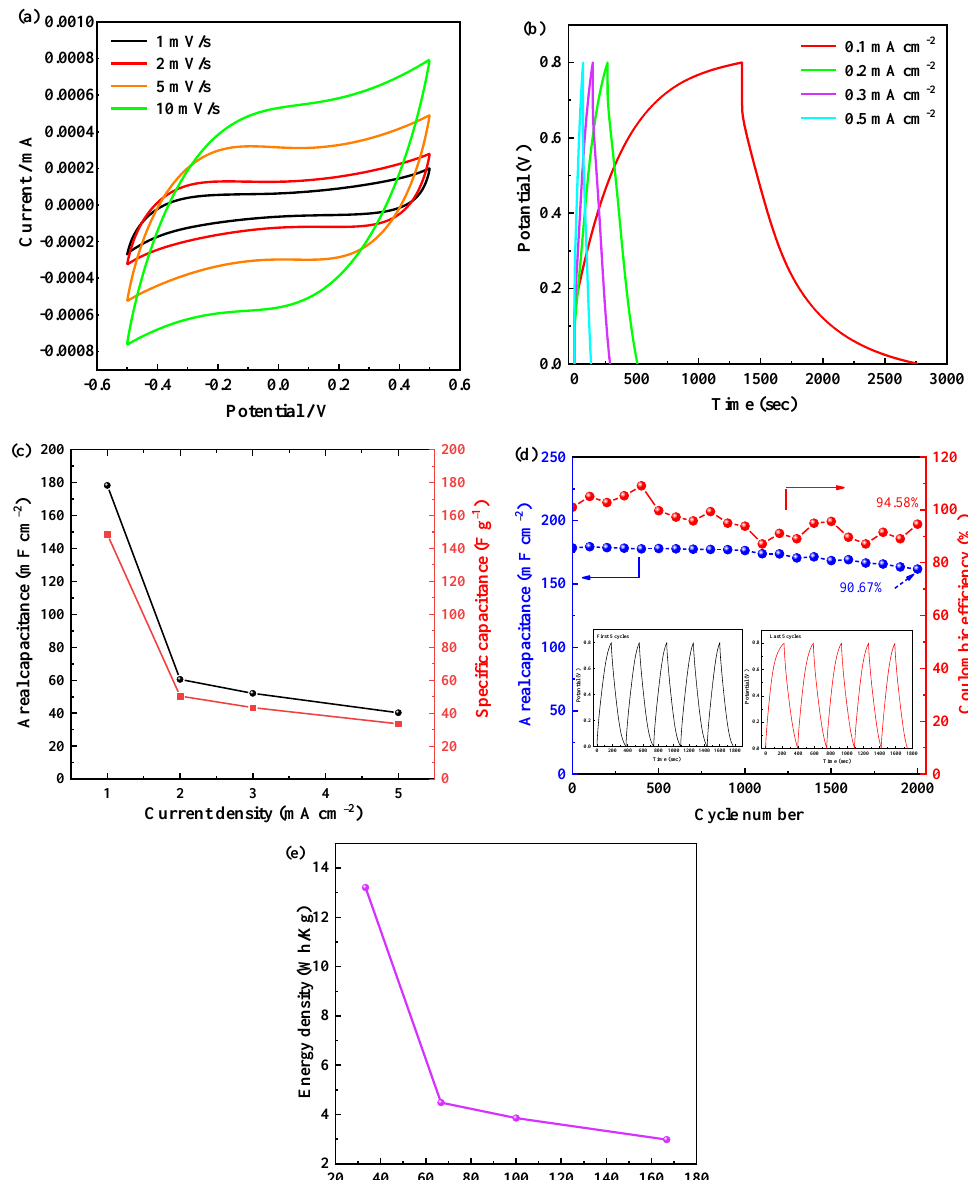
Figure 6. ( a ) CV curves at different scan rates; ( b ) GCD curves at various current density; ( c ) varia- tion of areal capacitance vs. current densities; ( d ) cycling stability and coulombic efficiency for 2 × 10 3 GCD cycles, and ( e ) Ragone plot of the device based on PC0.6. The galvanostatic charge/discharge curves of PC0.6 tested at different low current densities of 0.1, 0.2, 0.3, and 0.5 mA cm − 2 are shown in Figure 6b. As the current density increases from 0.1 to 0.5 mA cm − 2 , the discharge time decreases gradually. The device with PC0.6 exhibits quasi-triangle curves at different current densities demonstrating EDLC characteristics. The calculated areal and specific capacitances from the charge/discharge curves are shown in Figure 6c. The areal capacitances at 0.1, 0.2, 0.3, 0.5 mA cm − 2 are 178.28, 60.52, 52.06, and 40.28 mF cm − 2 , respectively. The specific capacitance of the device with PC0.6 varies from 148.57 F g − 1 to 33.56 F g − 1 as the charge/discharge current density increases from 0.1 to 0.5 mA cm − 2 . Figure 6d shows the cyclic stability test of the solid device based on PC0.6. It can be clearly observed that the areal capacitance and the coulombic efficiency of the device with PC0.6 remains 90.67% of initial capacitance